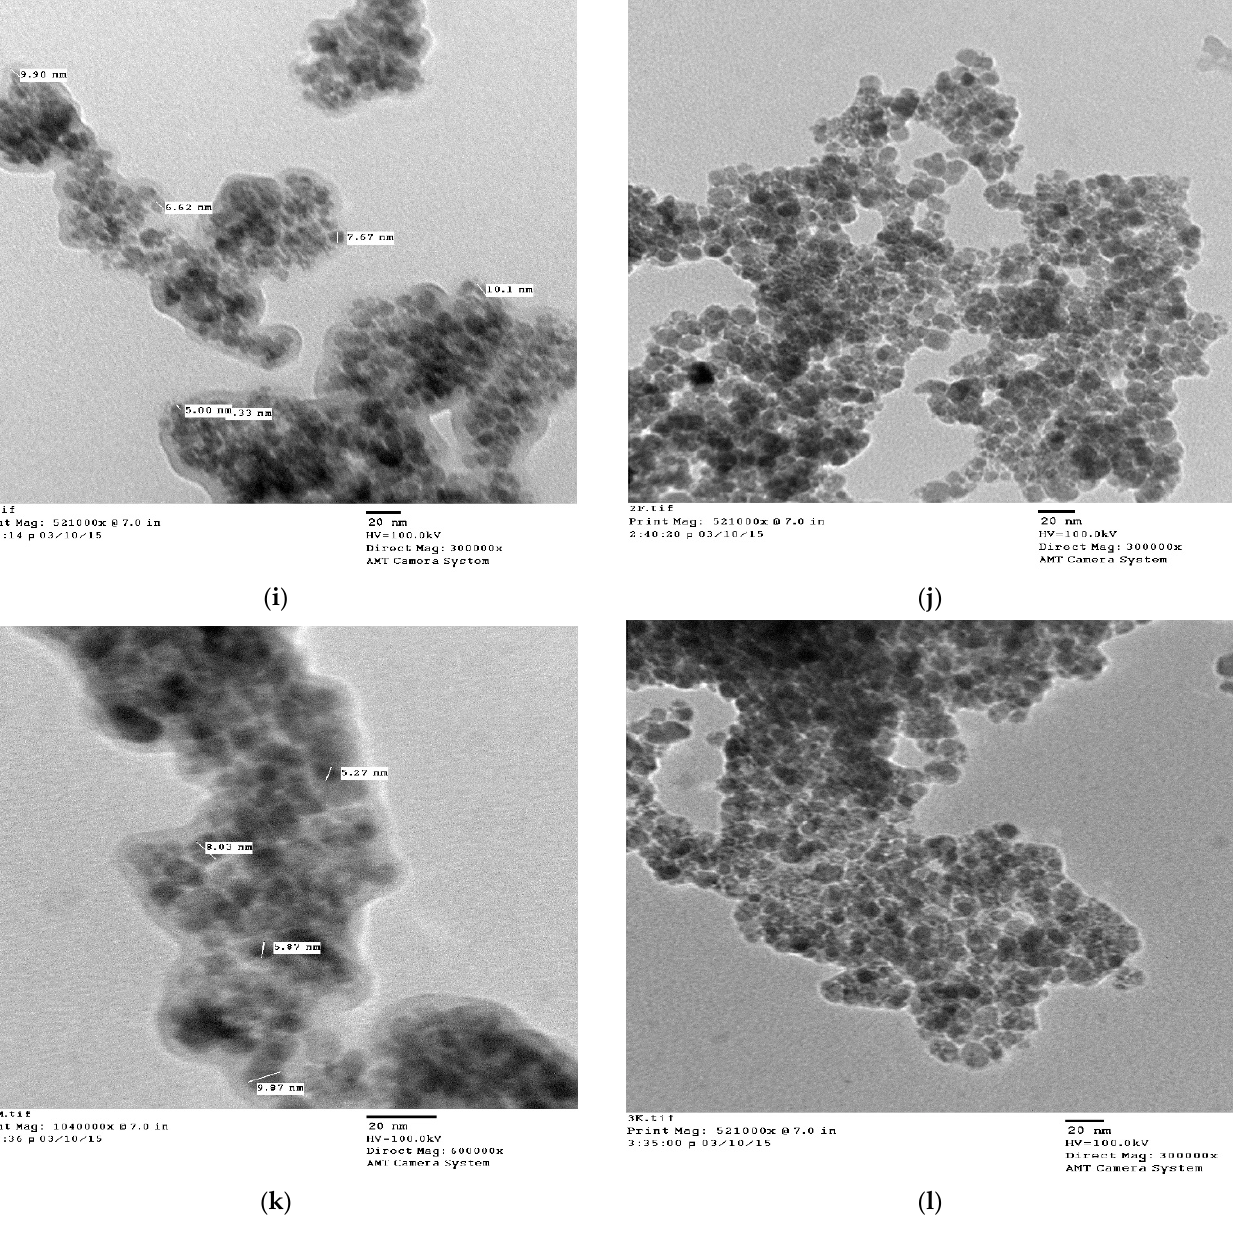
Figure 6. TEM images of ( a – d ) uncoated MNPs, ( e , f ) lauric-acid-coated MNPs, ( g , h ) oleic-acid- coated MNPs, ( i , j ) linoleic-acid-coated MNPs, ( k , l ) linolenic-acid-coated MNPs. MNPs, ( i , j ) linoleic-acid-coated MNPs, ( k , l ) linolenic-acid-coated